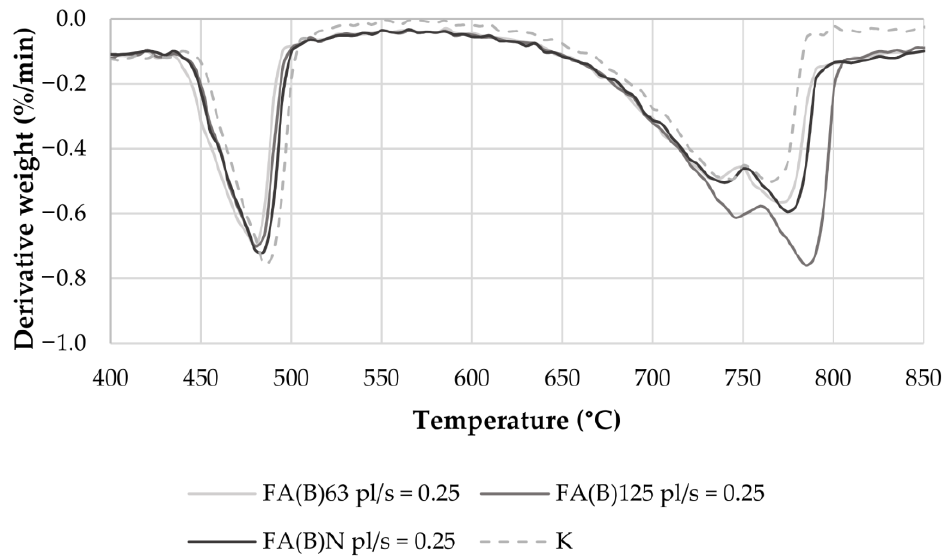
Figure 11. Derivative thermogravimetric (DTG) curves of mortars with a 25% addition of sieved fly ash (FA(B)63 or FA(B)125) compared with the results of mortars with a 25% addition of untreated fly ash (FA(B)N).